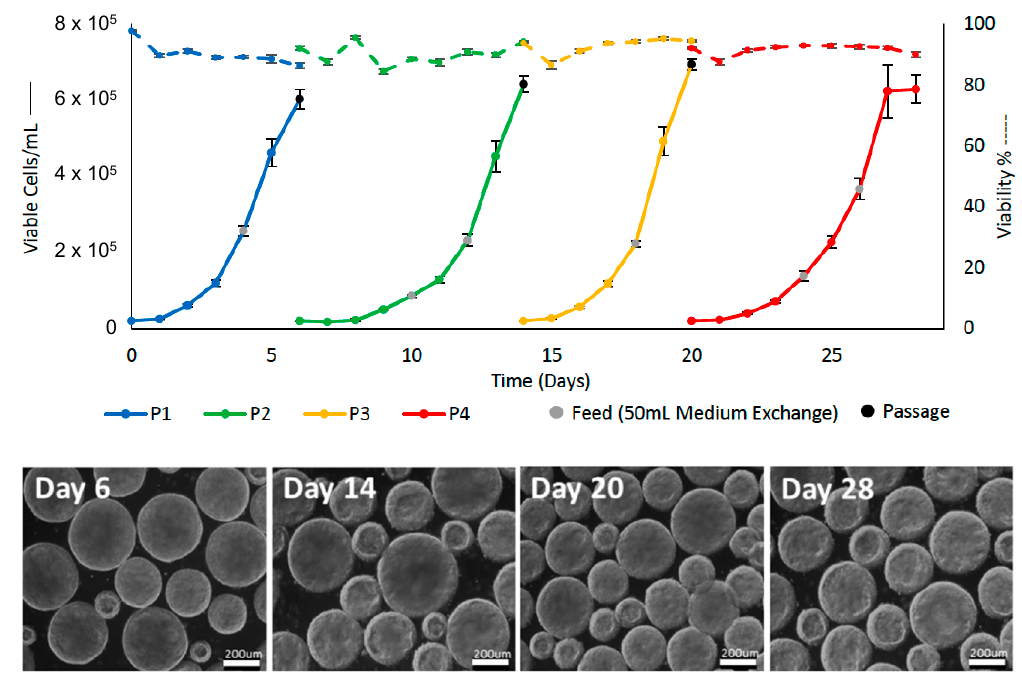
Figure 5. Successful Serial Passaging of iPSCs in 0.1 L Scale Vertical-Wheel Bioreactors.